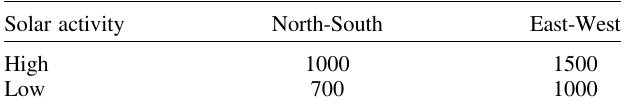
Table 1. Ionospheric (F region) correlation lengths (km) from McNamara